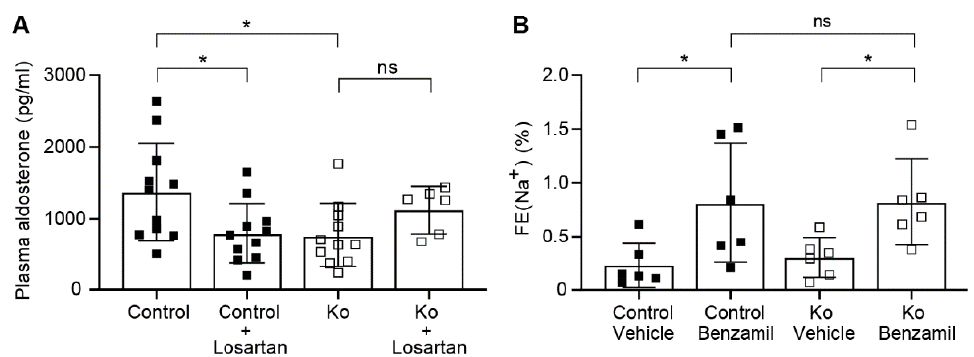
Figure 6. Under low Na + diet, the production of aldosterone was uncoupled from the renin-angiotensin system in Prss8 PaxLC1 Ko mice. ( A ) Plasma aldosterone levels in control (black square n = 11) and knockout mice (Ko, white square n = 6–11) under low Na + diet and treated or not with losartan (10mg/kgBW) for 7 days. ( B ) Natriuretic response expressed as fractional excretion of Na + (in %) in control (black square n = 6) and knockout mice (Ko, white square n = 6) treated with vehicle or acute treatment of benzamil (0.2mg/kgBW). All groups were treated during 7 days with losartan (10mg/kgBW). Results are presented as mean ± SD. ( A ) was analyzed by an unpaired two-tailed t test. ( B ) was analyzed with a two-way ANOVA with a Sidak’s multiple comparisons test (column factor: genotype; row factor: treatment). p values < 0.05 were considered statistically significant. * p < 0.05.